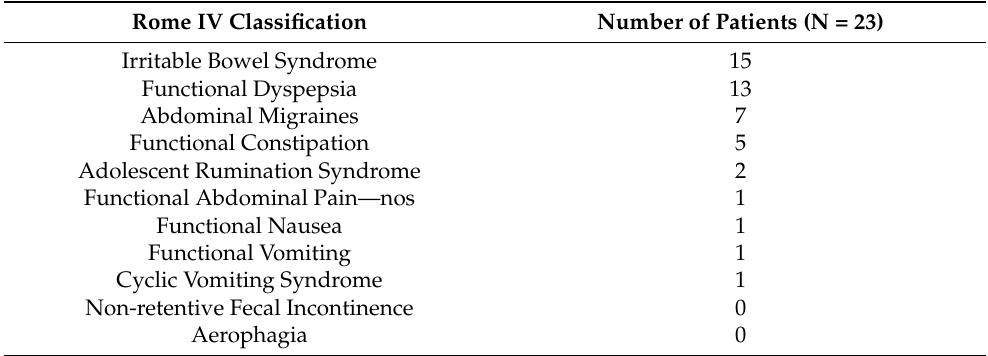
Table 1. The classification of children diagnosed with FAPDs according to Rome IV criteria. Rome IV